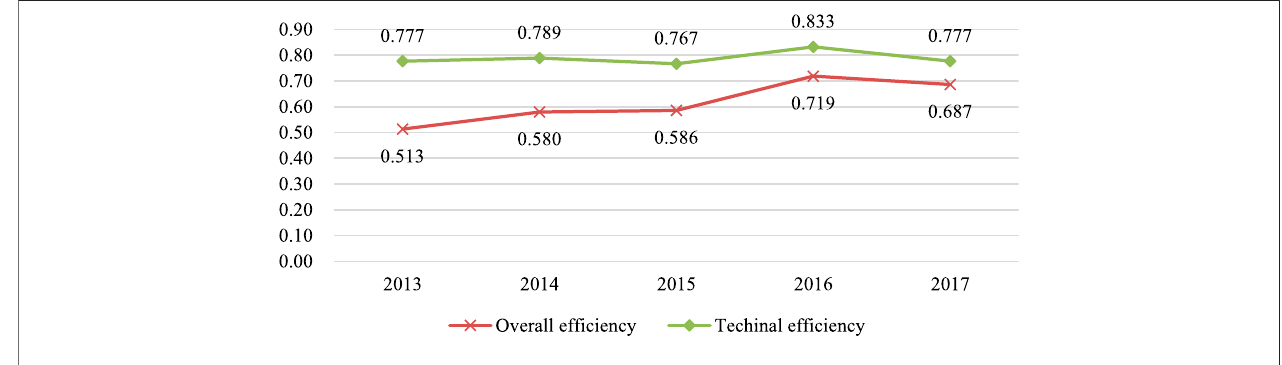
FIGURE 11 | Total ef fi ciency and technical ef fi ciency of China ’ s wind power industry.